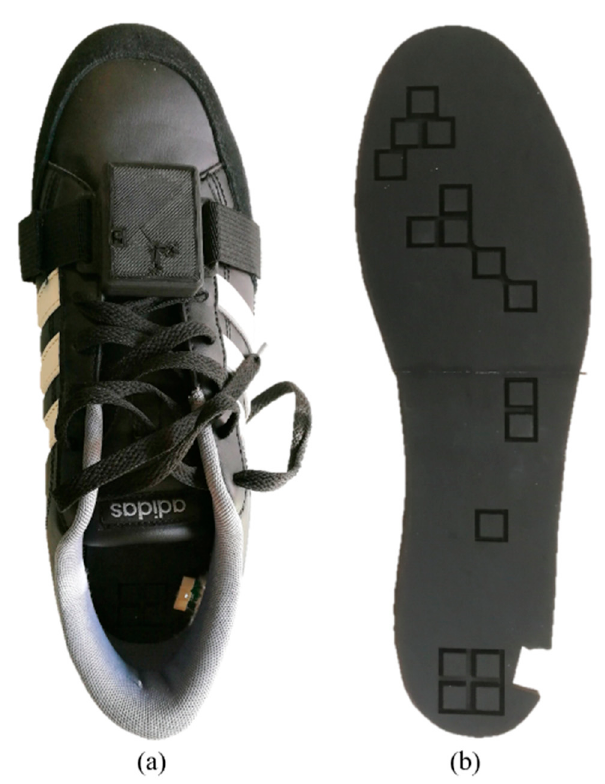
Figure 1. Prototype of pressure-sensitive insoles. ( a ) Shoes endowed with pressure-sensitive insoles. ( b ) Silicone cover.